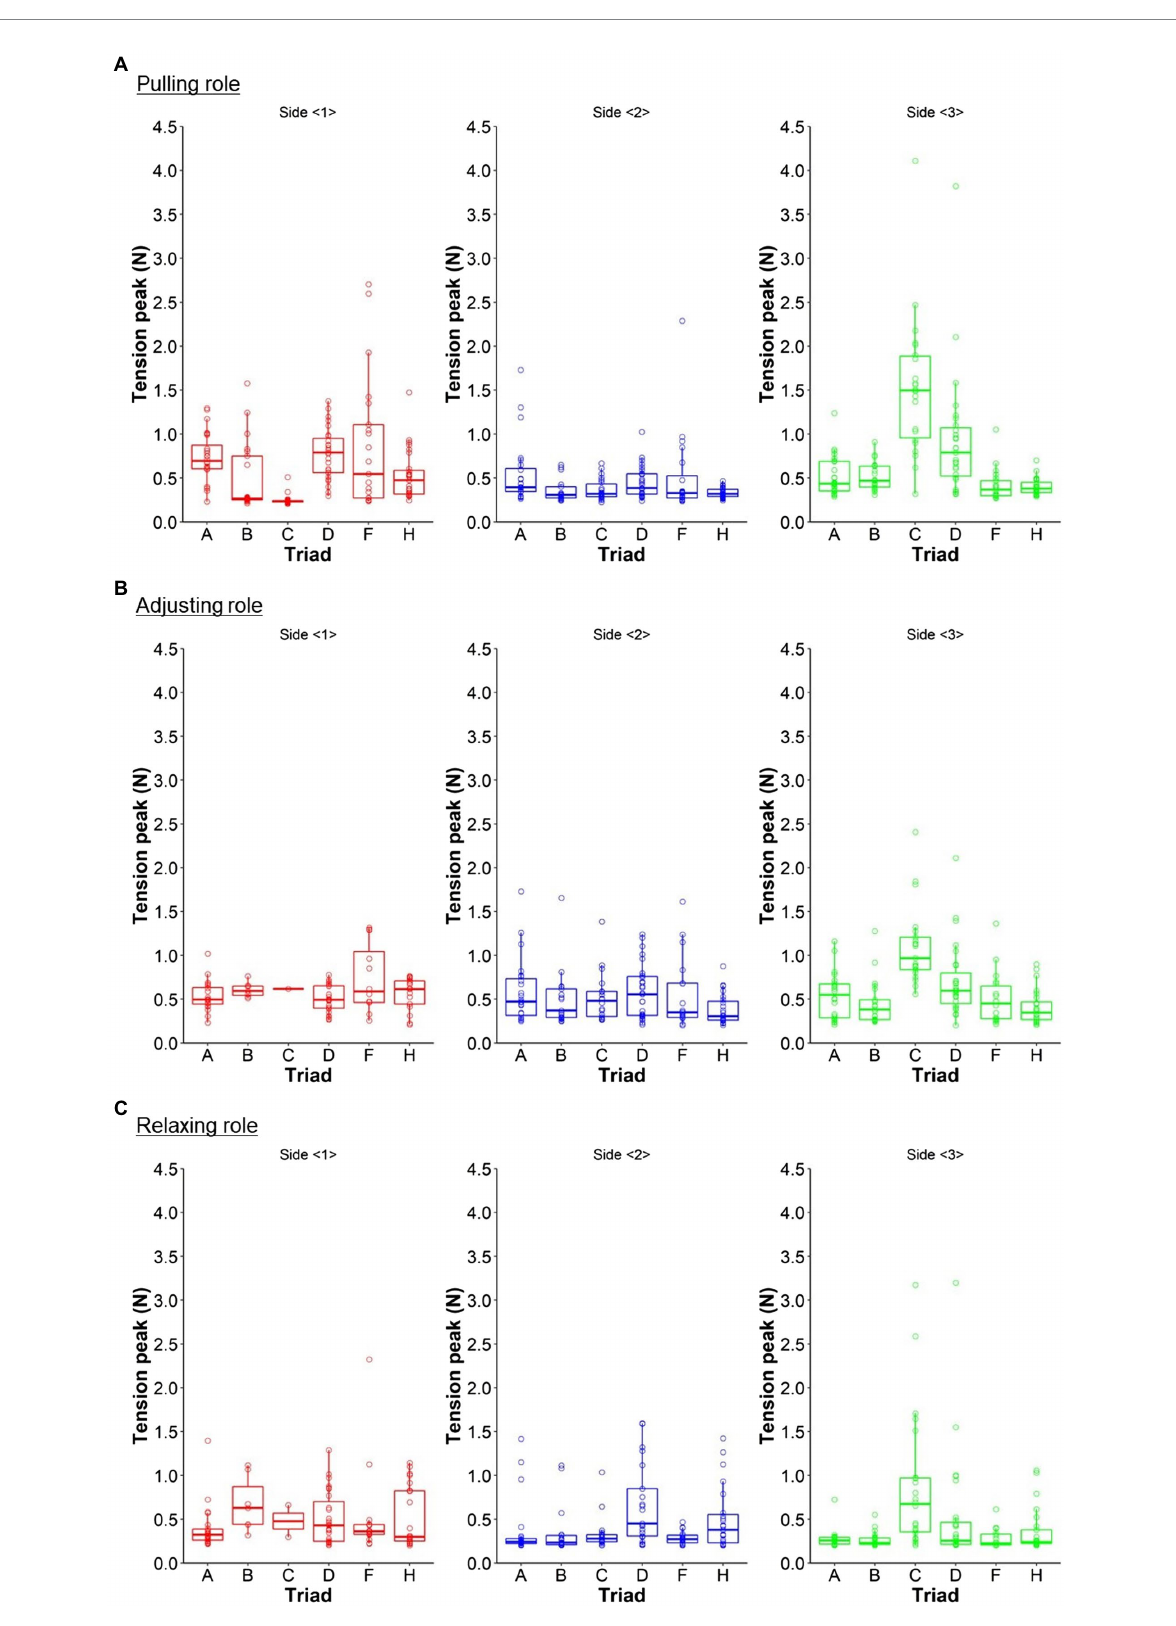
FIGURE 4 Box-and-whisker chart and plot of the tension peak value (N) of each trial on each side in each role. (A,B) Show the average values in the pulling and adjusting roles, respectively. (C) Represents the minimum one in the relaxing role. Triads E and G were excluded from all the analyses, as they did not engage in the task according to the experimenter’s instructions. For reference, these tensions vary between the triads or